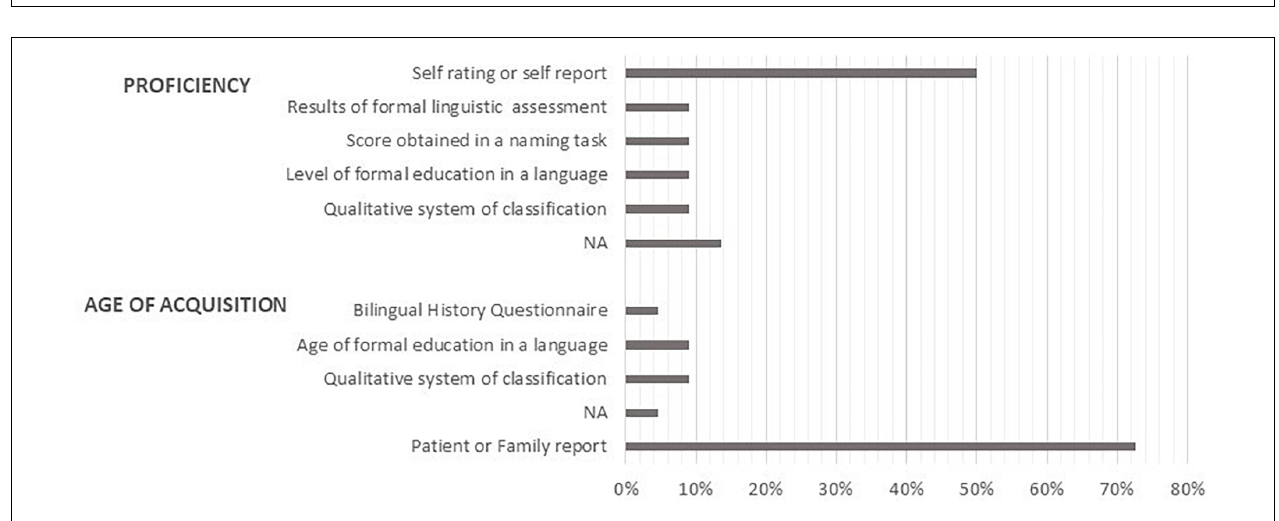
FIGURE 2 | Patient information: lesion site, number of languages spoken, sex, handedness, and aetiology.